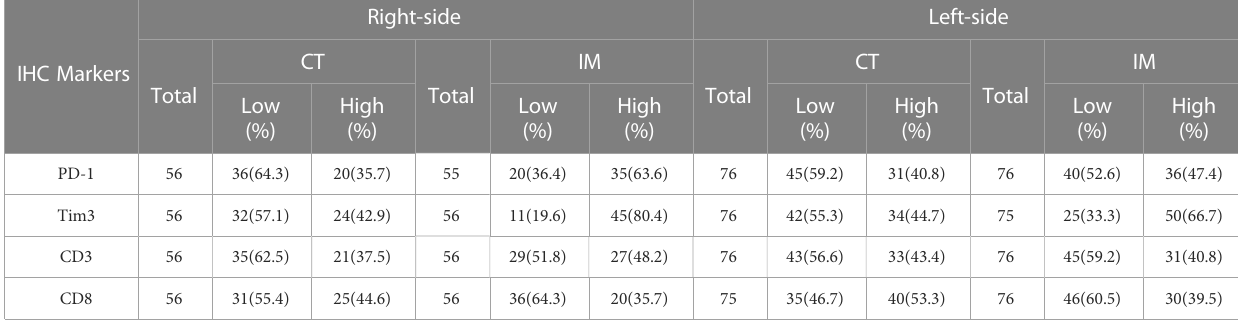
TABLE 3 Distribution of CD3+, CD8+, and PD-1+ TIL and Tim3+ TIICs at IM and CT according to the primary tumor side.